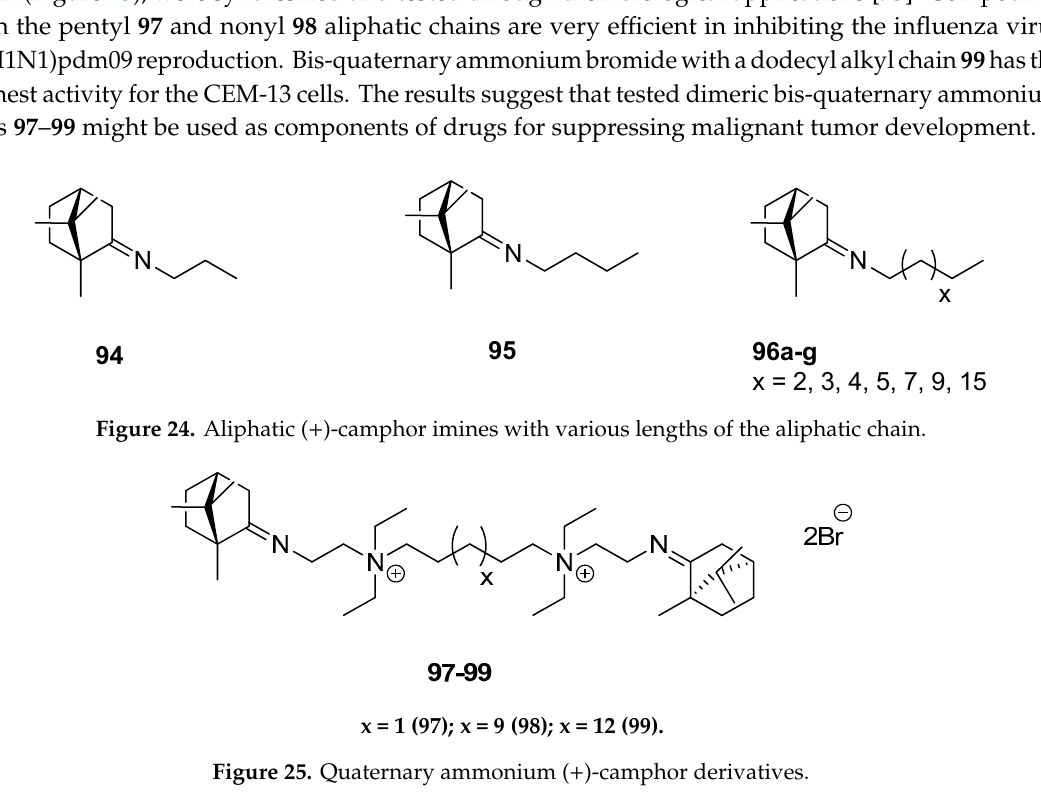
Figure 23. Camphecene—compound based on (+)-camphor and aminoethanol.